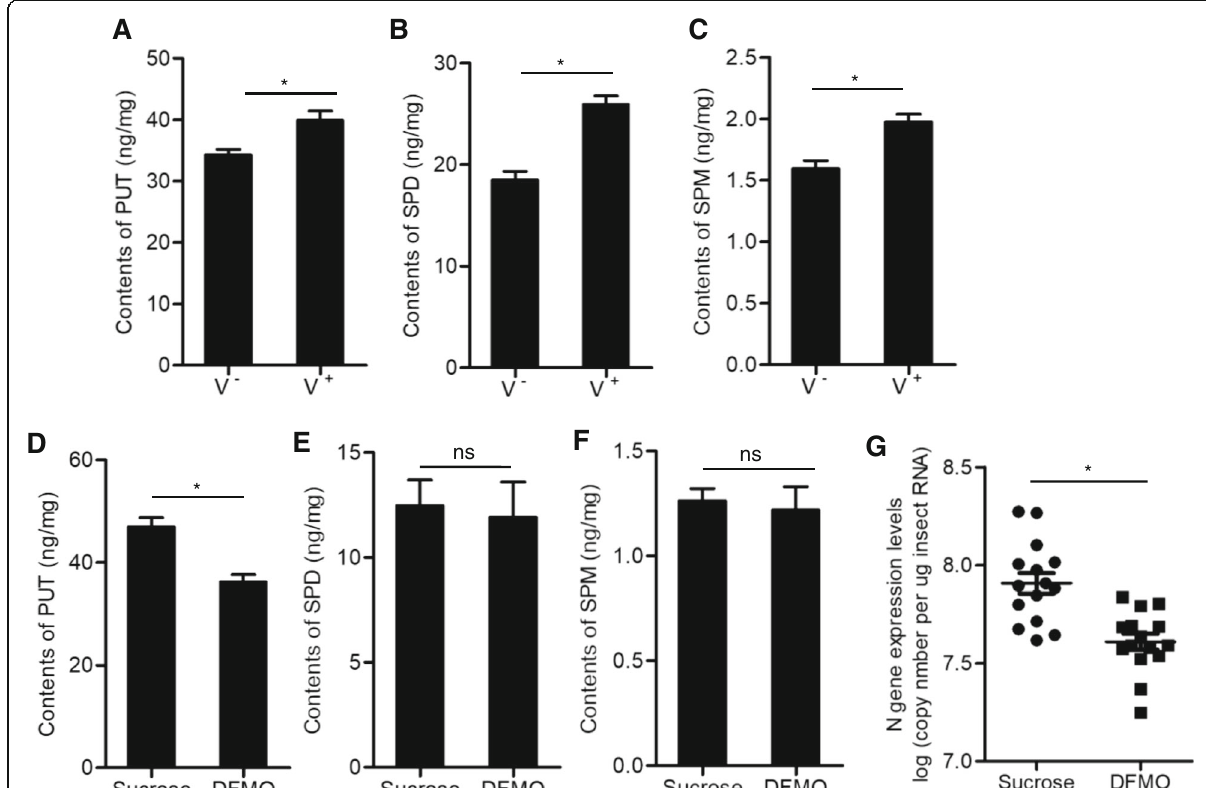
Fig. 3 RSMV infection increased polyamines production in R. dorsalis . A-C The contents of PUT ( A ), SPD ( B ) and SPM ( C ) in viruliferous or nonviruliferous insects, as detected by UPLC-MS/MS assay. D-F The contents of PUT ( D ), SPD ( E ) and SPM ( F ) in viruliferous insects treated with DFMO or sucrose control, as detected by UPLC-MS/MS assay. Data in A - F are presented as means (± standard deviation) from three independent experiments (Student ’ s t -test, two tailed). *, P < 0.05. ns, non-significant. G The expression levels of RSMV N in viruliferous insects treated with DFMO or sucrose control. The N gene copy number in individual insects was detected by RT-qPCR assay. Each horizontal line represents the mean gene copy number of each data set. The significance of difference was tested using Tukey ’ s HSD test. *, P <